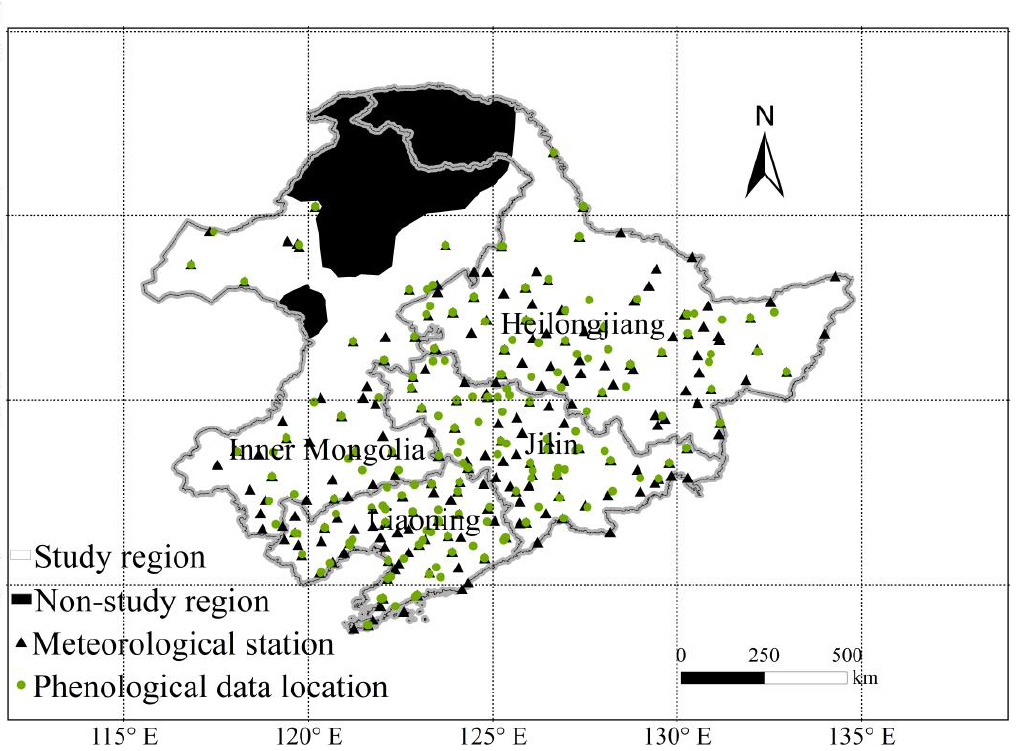
Figure 1. Spatial distribution of meteorological station and phenological data location in Northeast China.